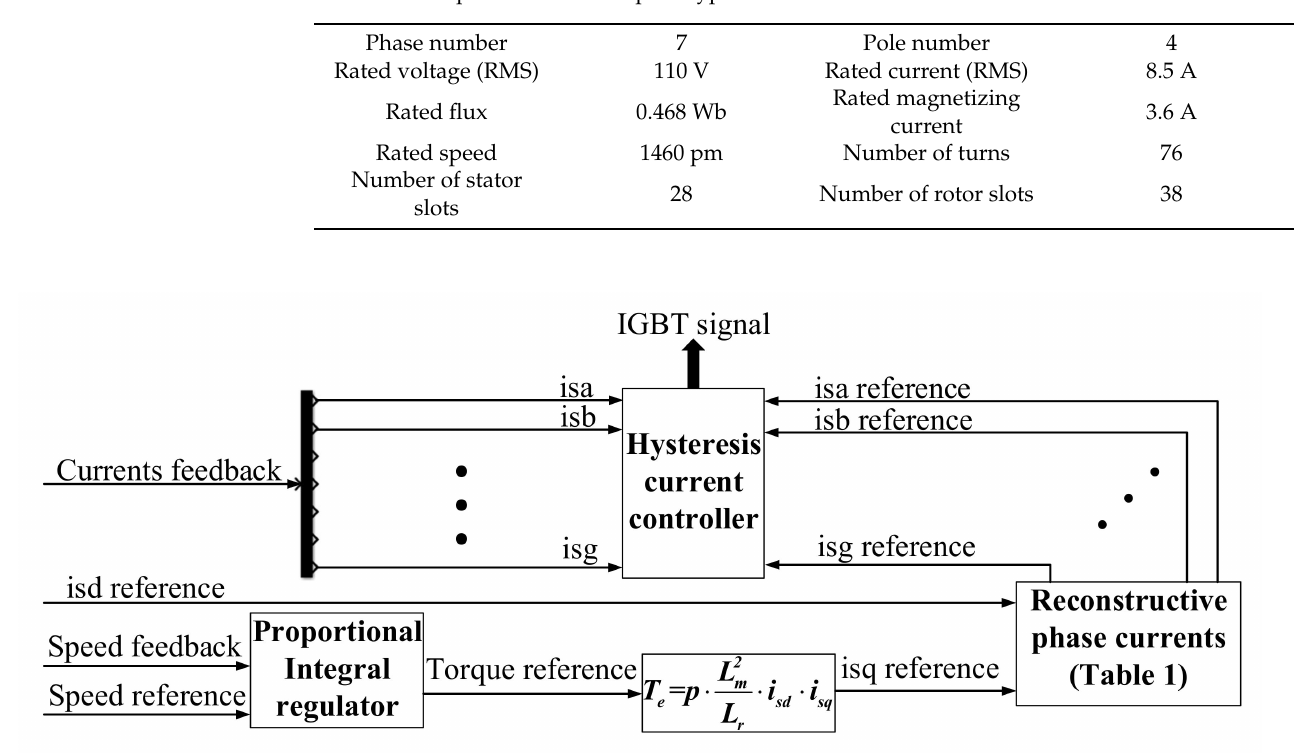
Table 3. Main parameters of the prototype.